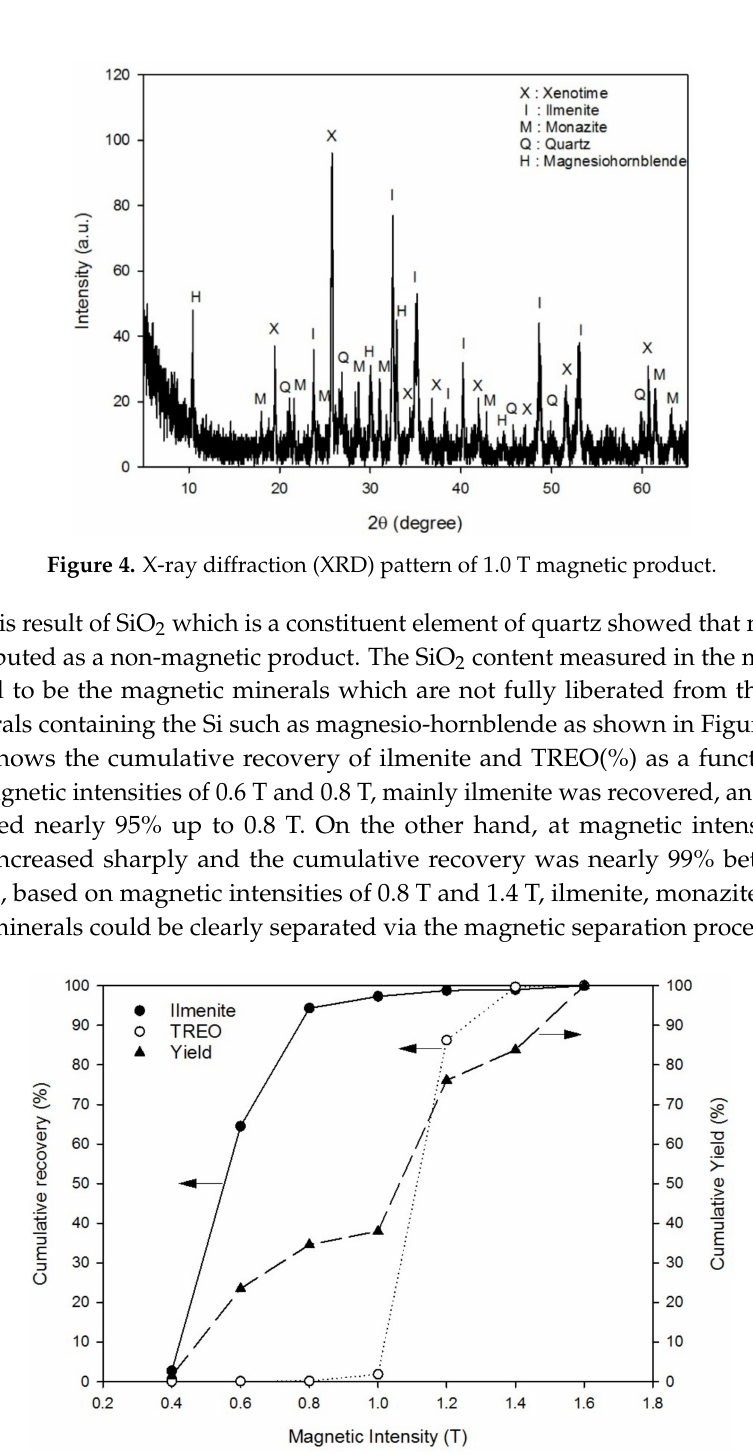
Figure 5. Cumulative recovery of ilmenite and TREO (%) as a function of magnetic